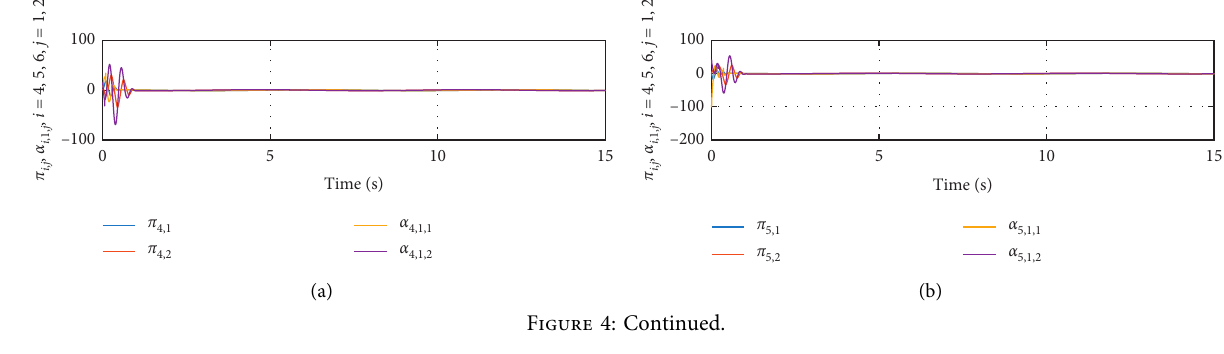
Figure 3: Response curves of π